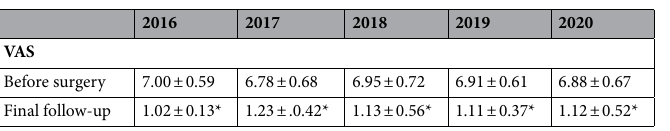
Table 4. VAS score of OVCF patients over 5 years. *Before treatment vs. final follow-up, P < 0.05.